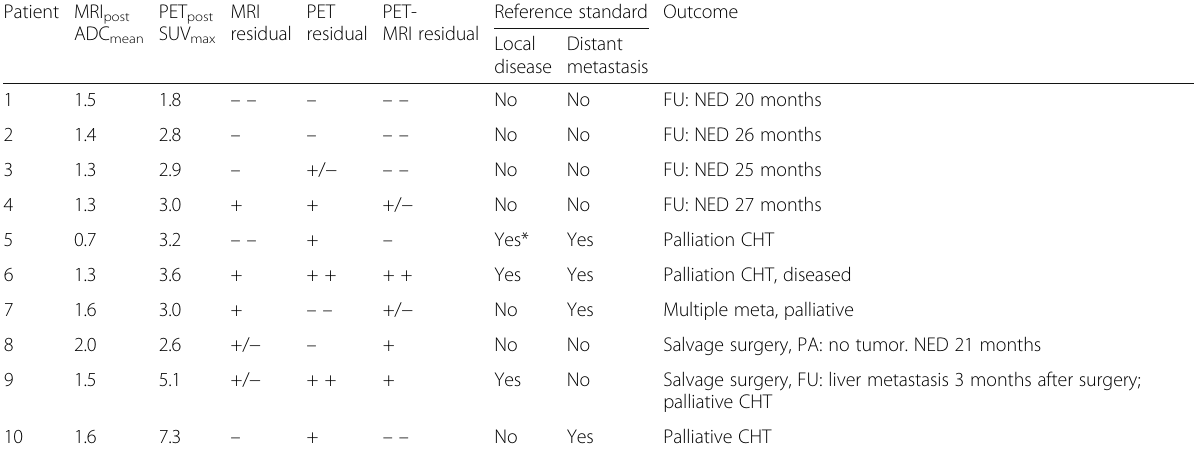
Table 2 Score for local residual tumor based on MRI (radiologist), PET (nuclear physician), and PET-MRI (consensus radiologist and nuclear physician) performed 3 months after treatment, quantitative measurements, reference standard, and outcome Patient MRI post PET post MRI PET PET- Reference standard Outcome ADC mean SUV max residual residual MRI residual Local Distant disease metastasis